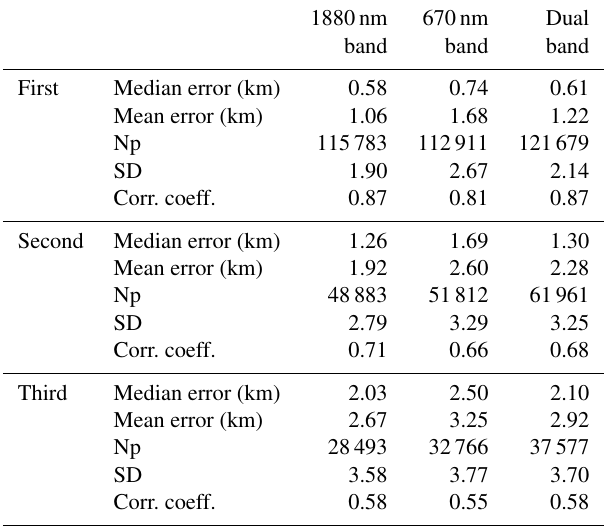
Table 1. Summary of baseline